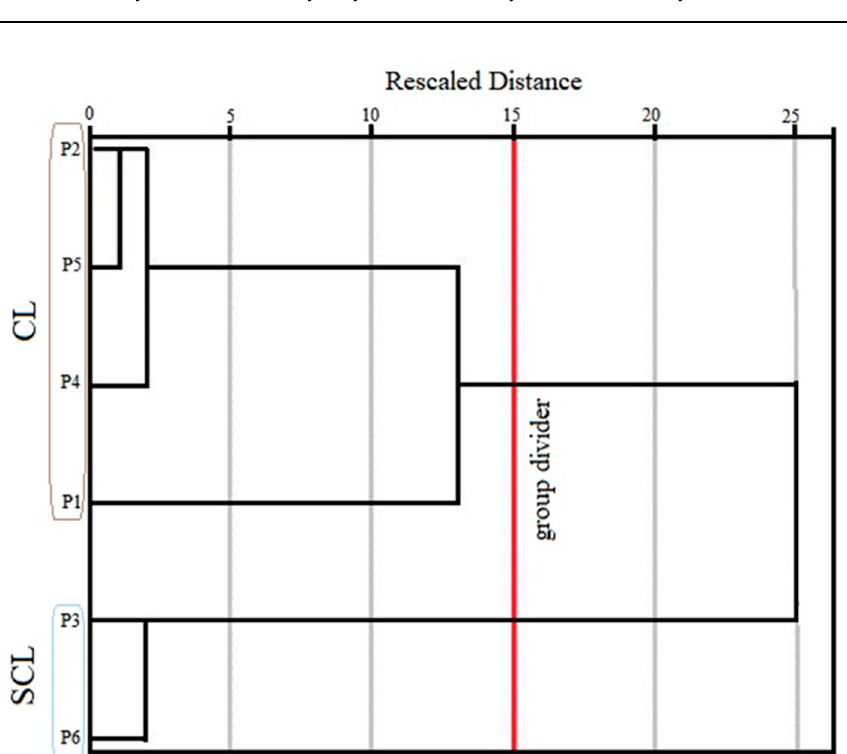
Figure 7. Cluster analysis results concerning the plots’ soil characteristics. CL represents the clay loam cluster and SCL represents the sandy clay loam cluster.